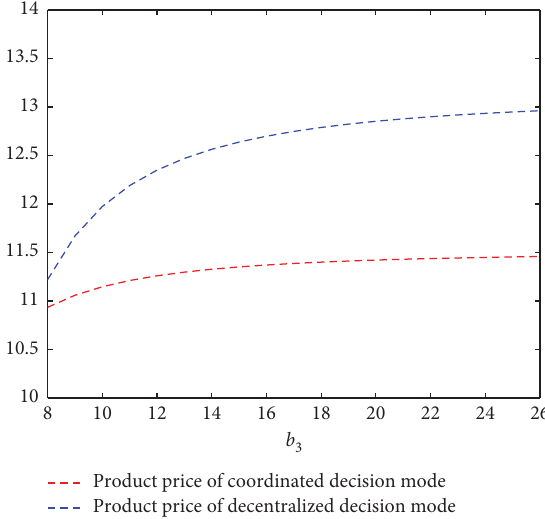
Figure 5: Influence of b